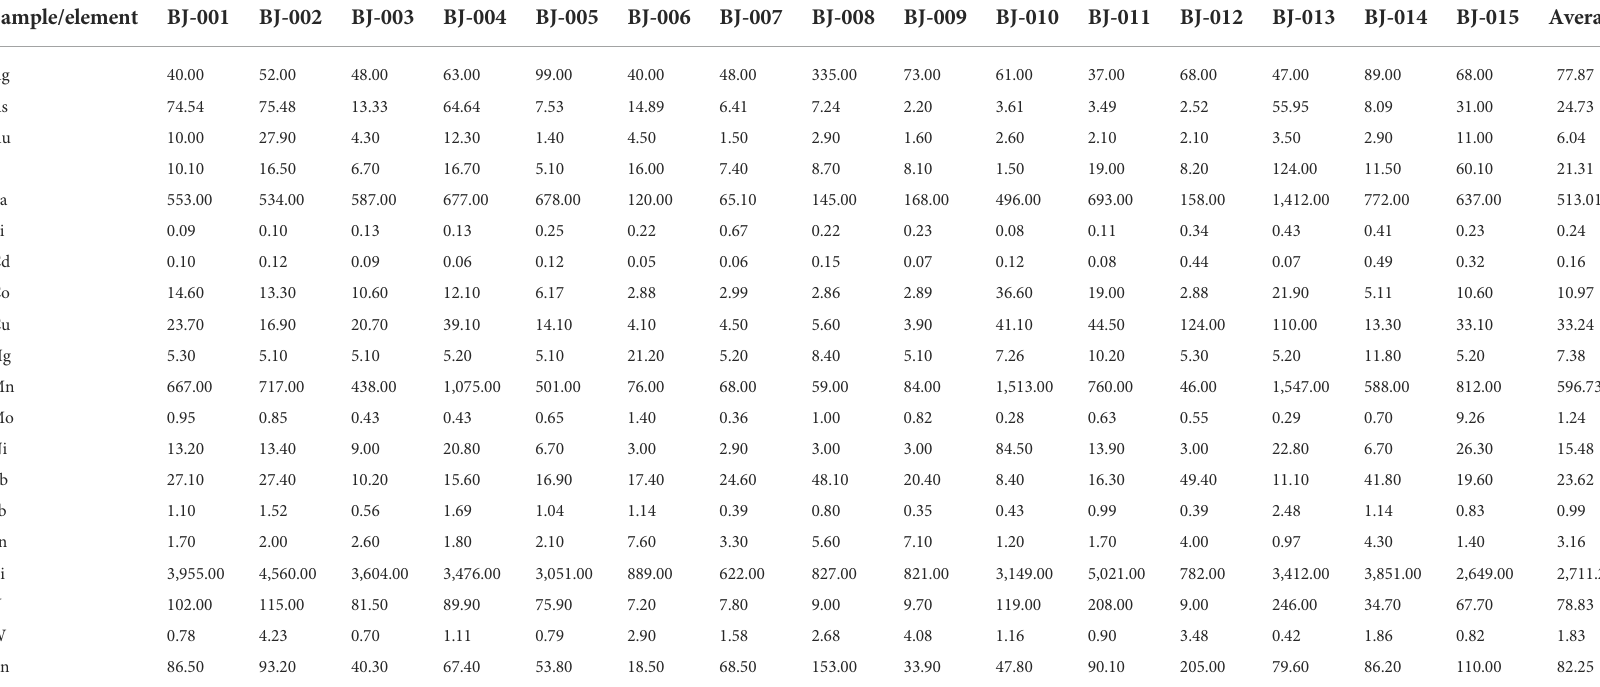
TABLE 2 Gold and path fi nder elements in wallrock samples from the Hongqigou tectonic zone (Ag and Au in ppb, other elements in ppm).